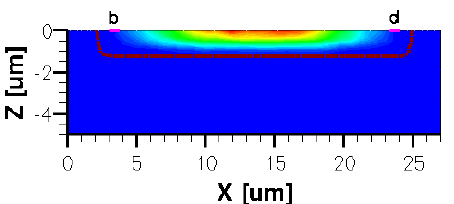
Figure 18. Conduction current density for basic cell, with emphasis on the sensing contacts b and d (Y =